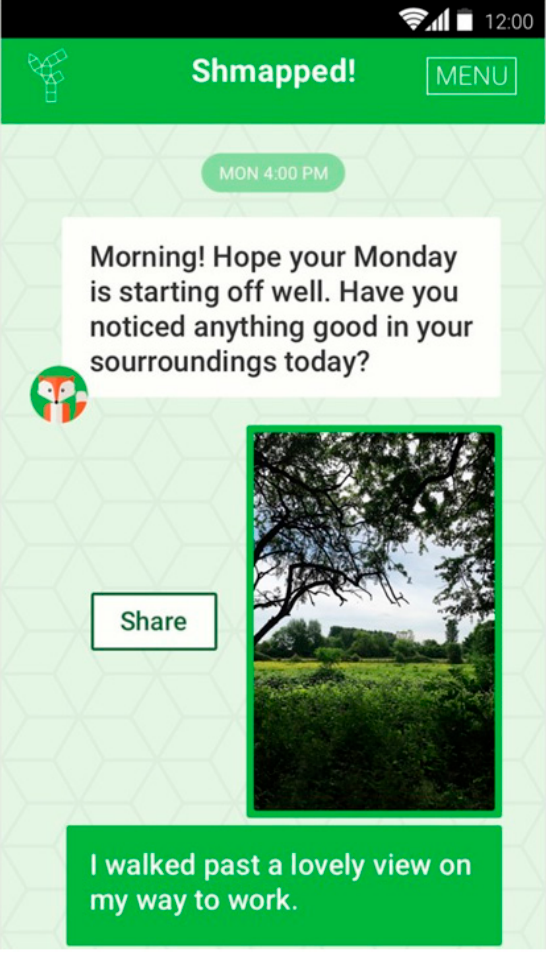
Figure 1. Screenshot of one of the app screens.